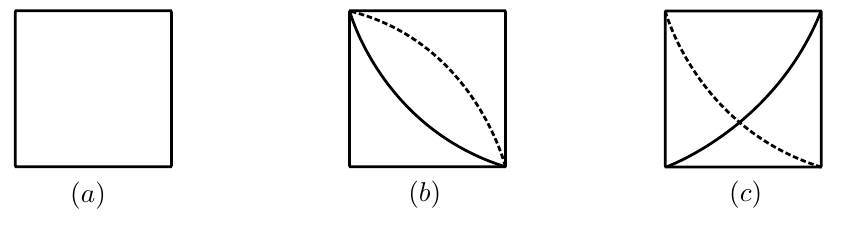
Figure 5 . The three type of planar Wick contractions between four operators at weak coupling; each line represents a non-empty bundle of propagator. The respective symmetry factors are 1, k + 1 and 2, where k is the number of diagonal